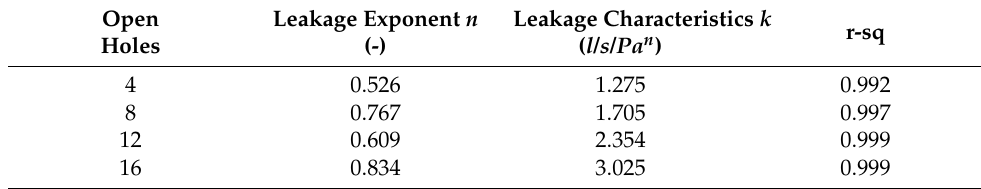
Table 2. Initial conditions of test enclosure.